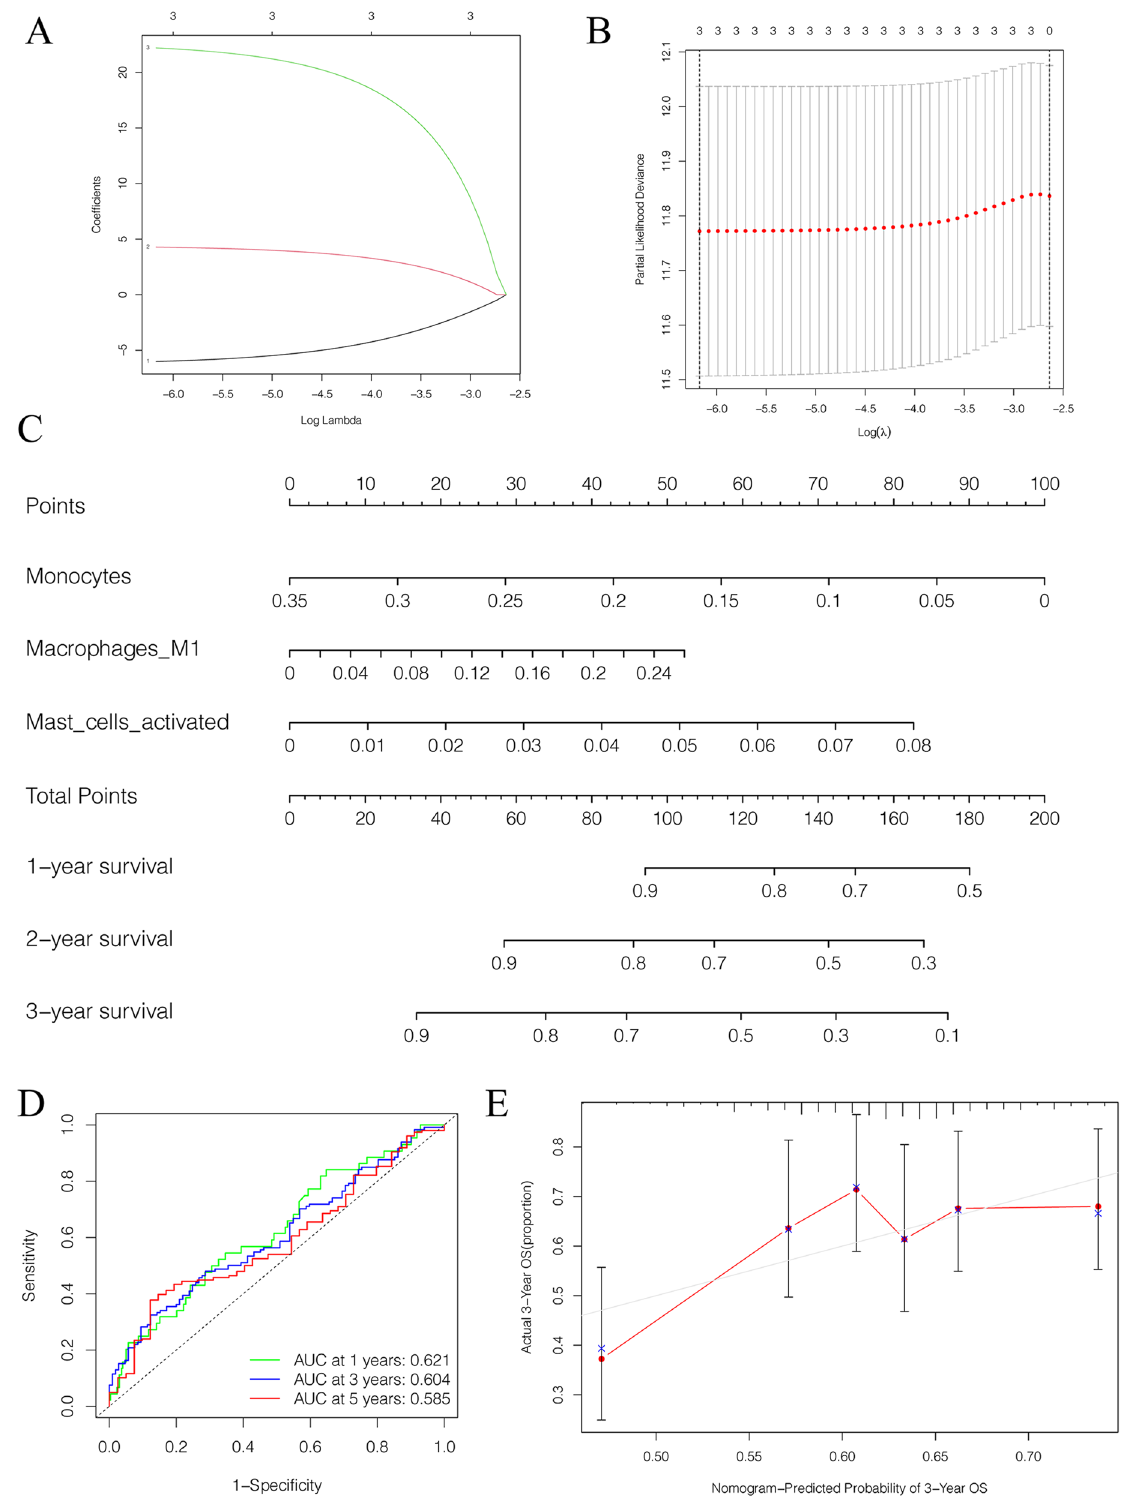
Figure 7. Identification of prognostic value of immune cells in lung adenocarcinoma. ( A , B ) The Lasso regression suggested that 3 immune cells were essential for prognostic prediction model. ( C ) The nomogram based on the immune cells model. ( D ) The ROC curves showed that the area under curve at 1 year was 0.621, at 3 year was 0.604, and at 5 years was 0.585. ( E ) The calibration curves validated the